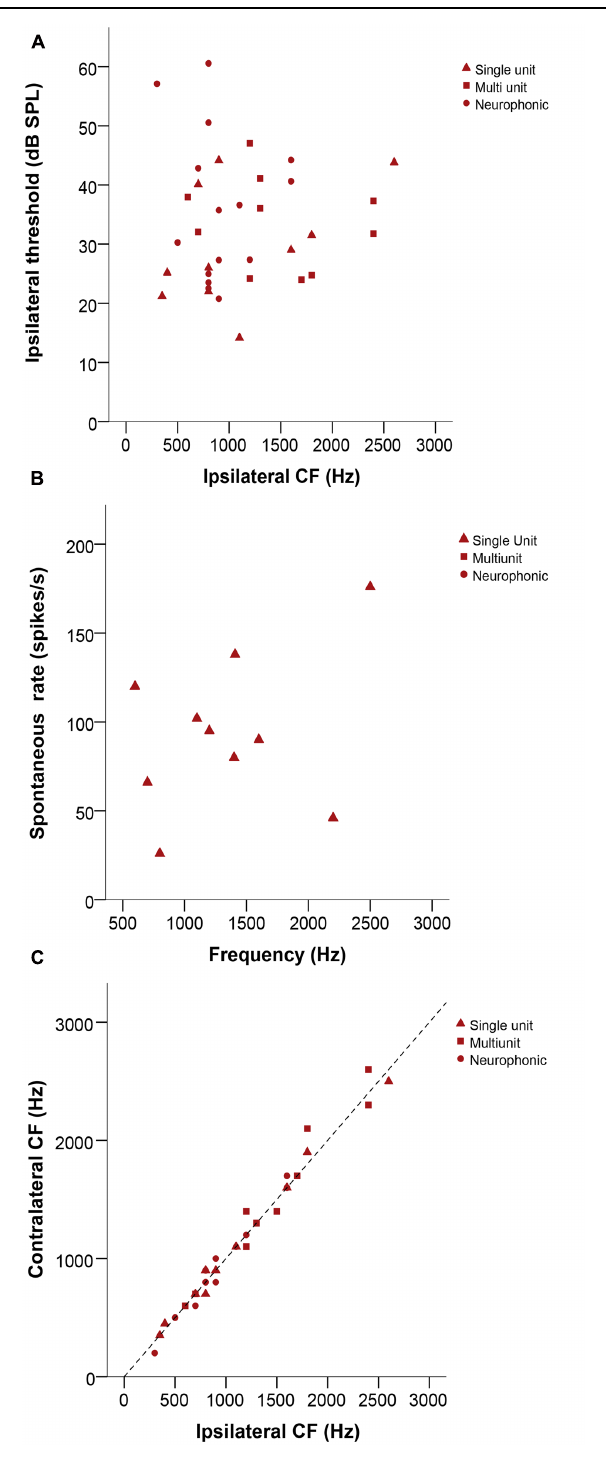
FIGURE 3 | (A) Ipsilateral threshold in dB SPL as a function of ipsilateral CF in Hz. (B) Plot representing spontaneous rate in spikes/s as a function of frequency (Hz). (C) Ipsilateral versus contralateral characteristic frequencies (CFs) in Hz. The dashed line represents X = Y. In all panels, triangles represent single-unit recordings, squares represent multi-unit recordings and circles represent neurophonic